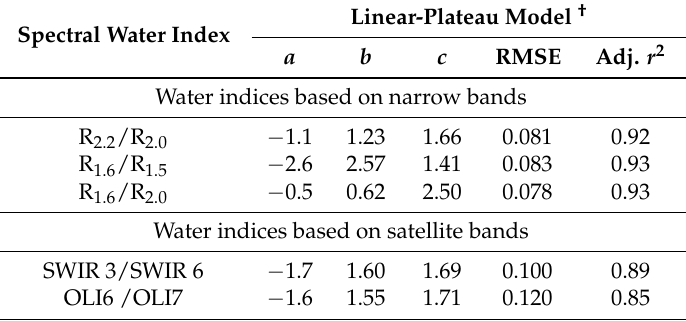
Table 7. Regression coefficients, RMSE and adjusted coefficient of determination (Adj. r 2 ) for the RWC of field measurements as a function of the water indices based on narrow bands (Figure 6) or on satellite-like bands extracted from the reflectance spectra measured in the field ( n = 410).